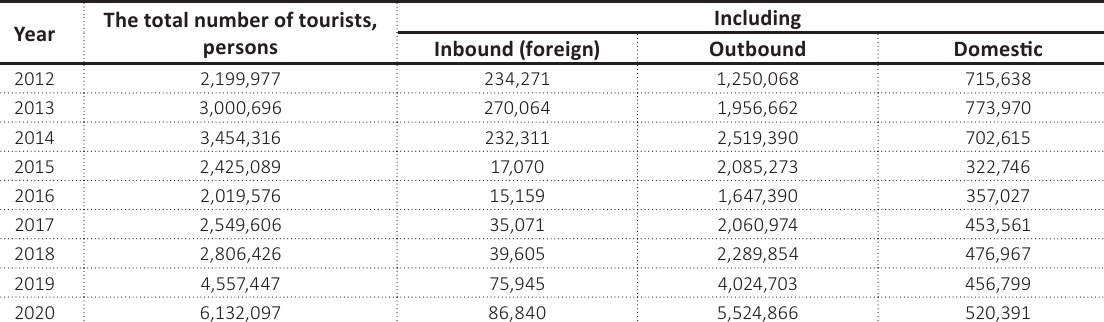
Source: State Statistics Service of Ukraine